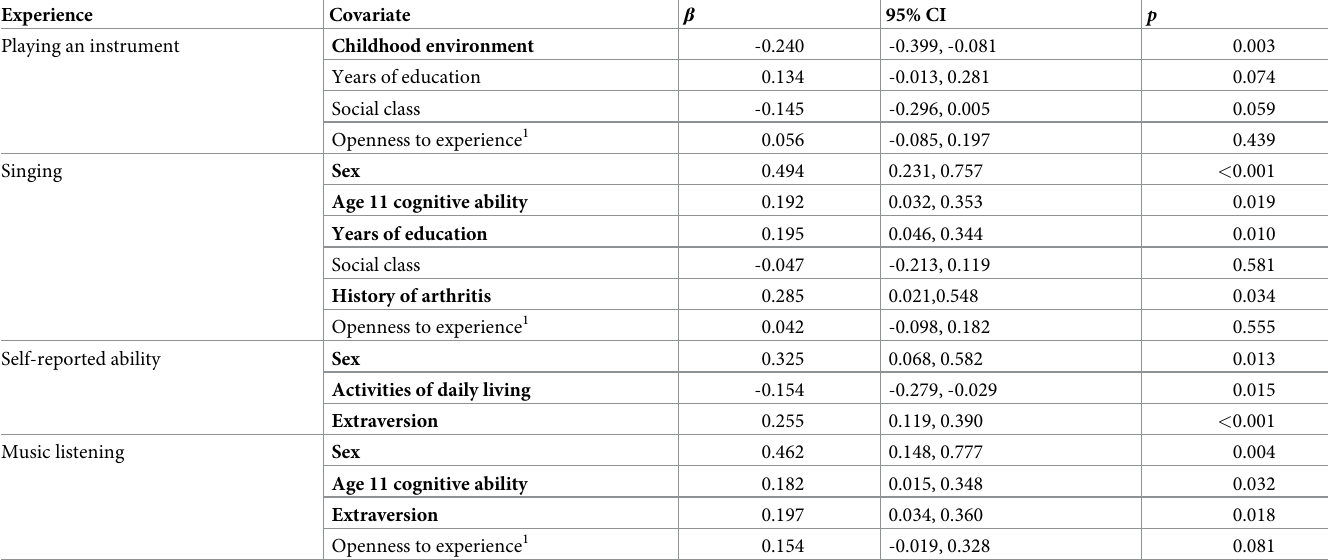
Table 4. Final model of lifetime musical experience and its non-musical lifespan